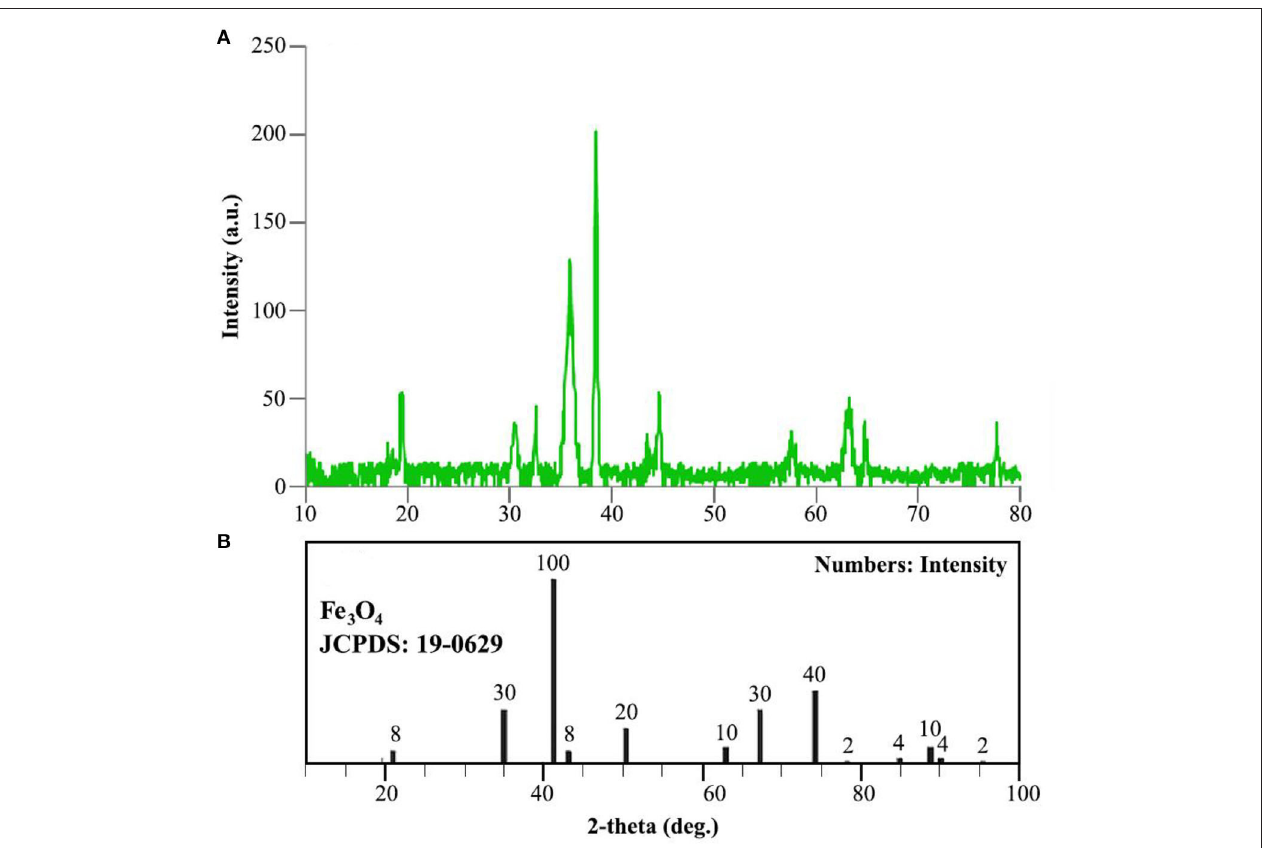
FIGURE 6 | XRD data of Fe 3 O 4 @PVA-Cu (A) and Fe 3 O 4 nanoparticles (B) .